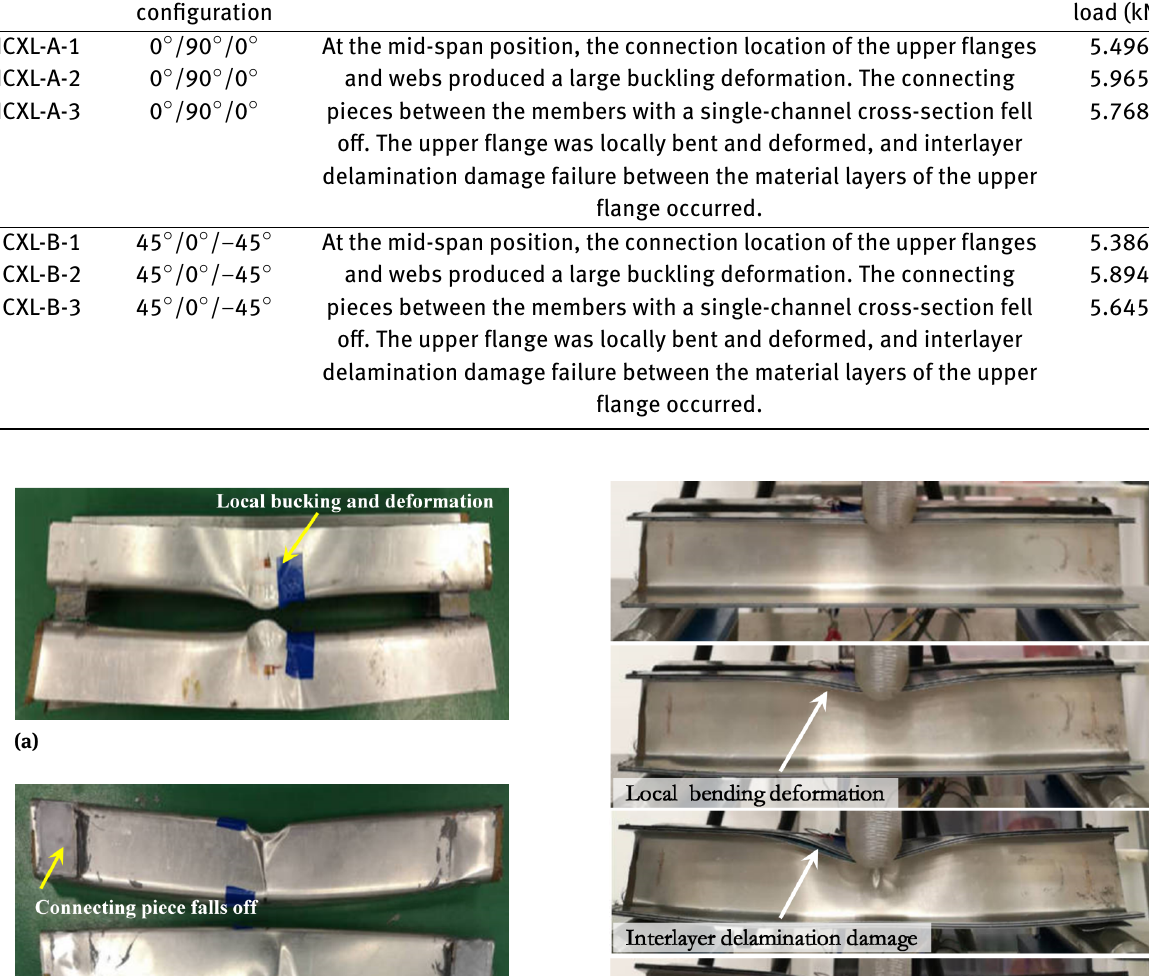
Table 2: Bearing capacity and failure modes of double-channel CARALL beams with different fiber layups. Specimen